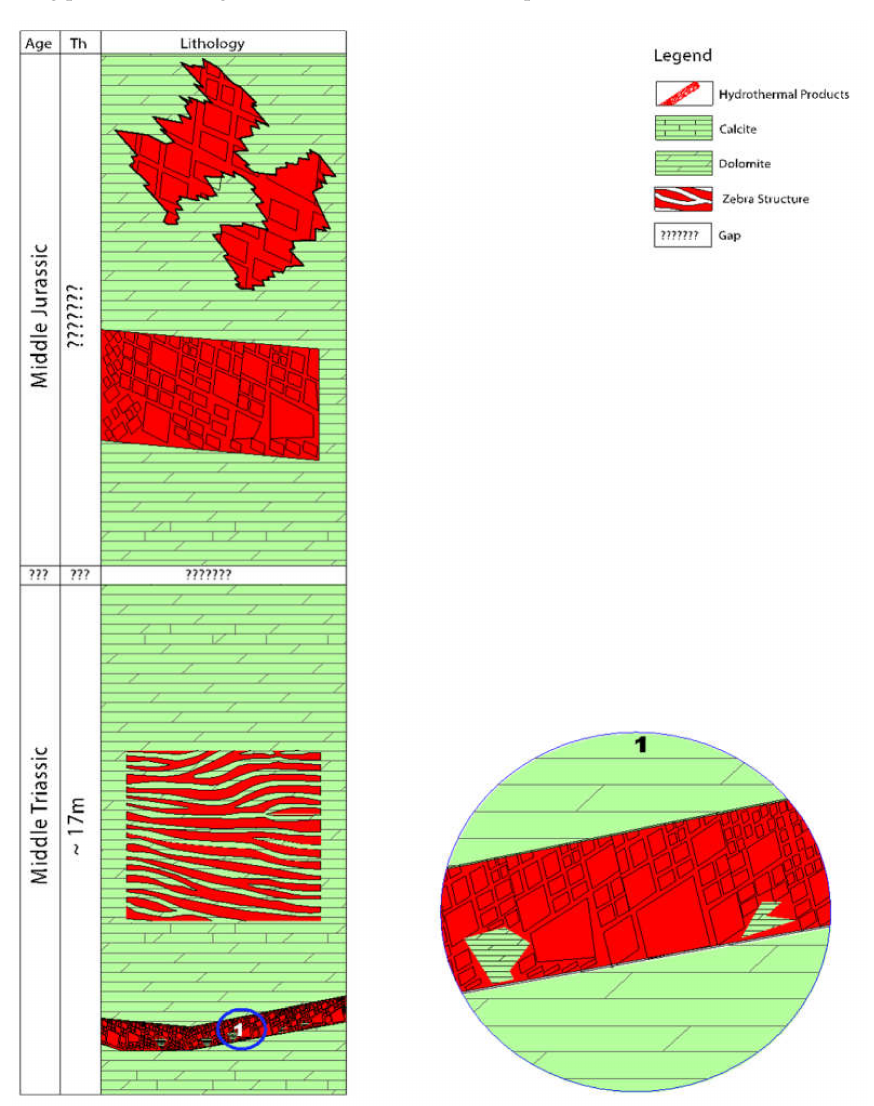
Figure 3. Basic stratigraphic litho-log of the Triassic and Jurassic carbonate rocks in Provençal Domain. The lower most part of Triassic rock (1) is extensively brecciated and the floated fragments have been cemented by saddle dolomite (see the enlarged part of this breccia on the right part “1”). The breccia is followed by another structure, i.e., zebra